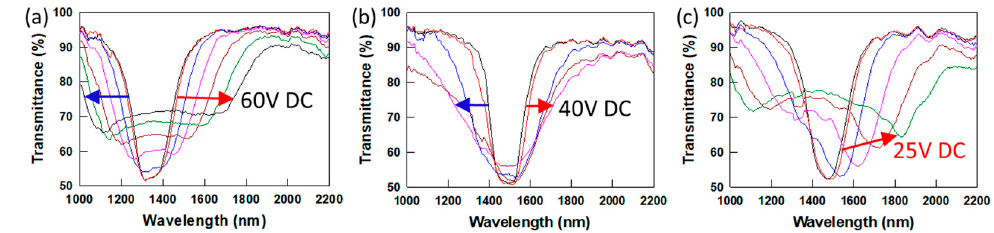
Figure 6. Transmission spectra of PSCLCs formulated with 3.5 wt% R1011, 90.5 wt% MLC-2079 and